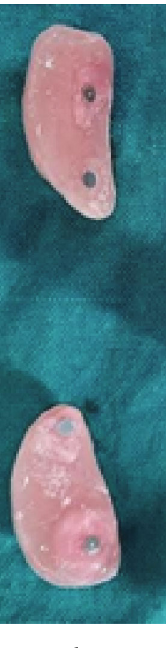
Figure 3: Cheek plumpers showing magnetic attachments.